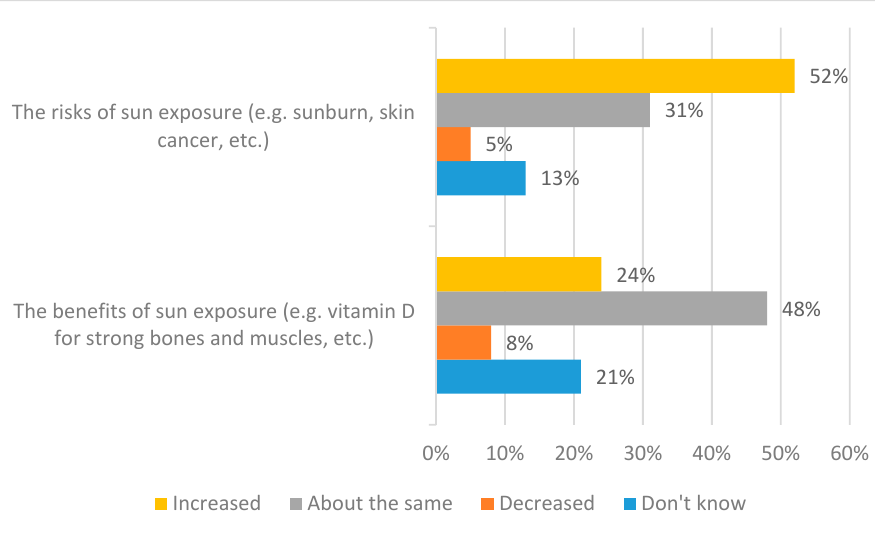
Figure 2. Awareness of change in the promotion of the risks and benefits of sunlight exposure over the past ten years.